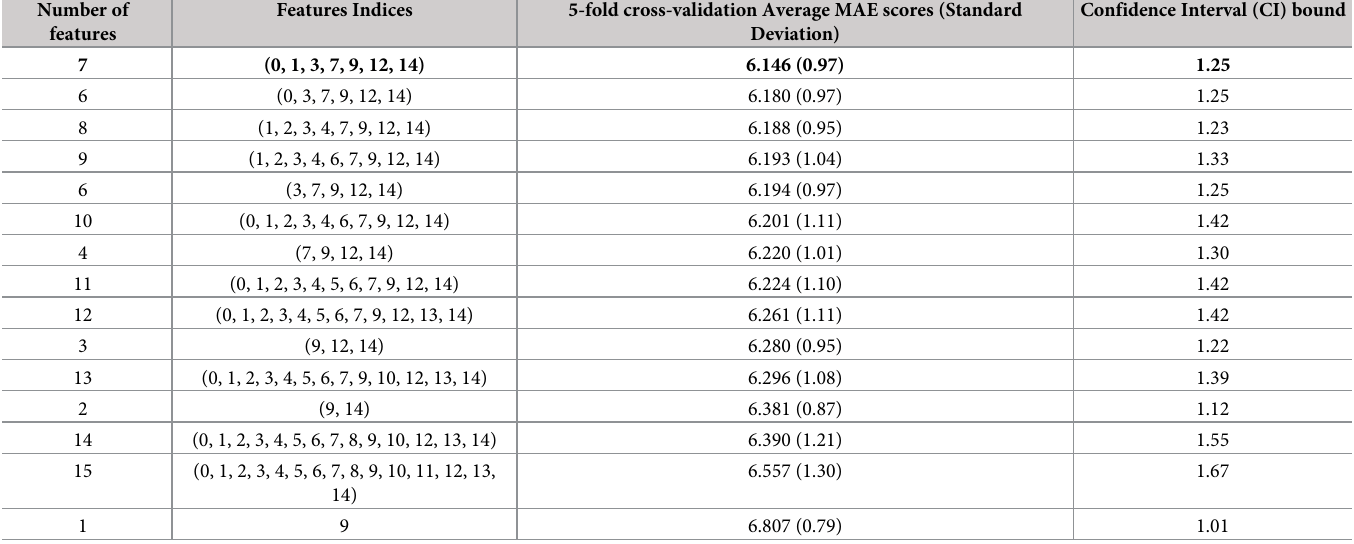
Table 4. Output from SBFS ranked in descending order.